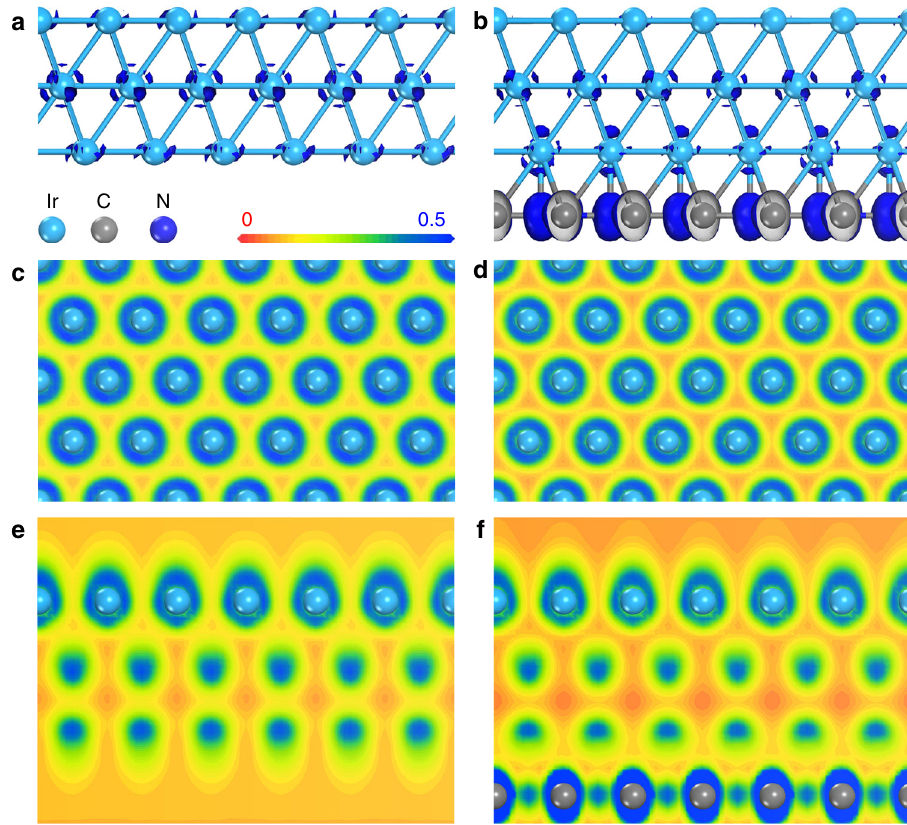
Fig. 2 Theoretical calculations of the orbitals for Ir and IrNC. a , c , d The isosurface and slices from the top/side-view of the orbitals above the Fermi level for Ir, respectively. b , d , f The isosurface and slices from the top/side-view of the orbitals above the Fermi level for IrNC,